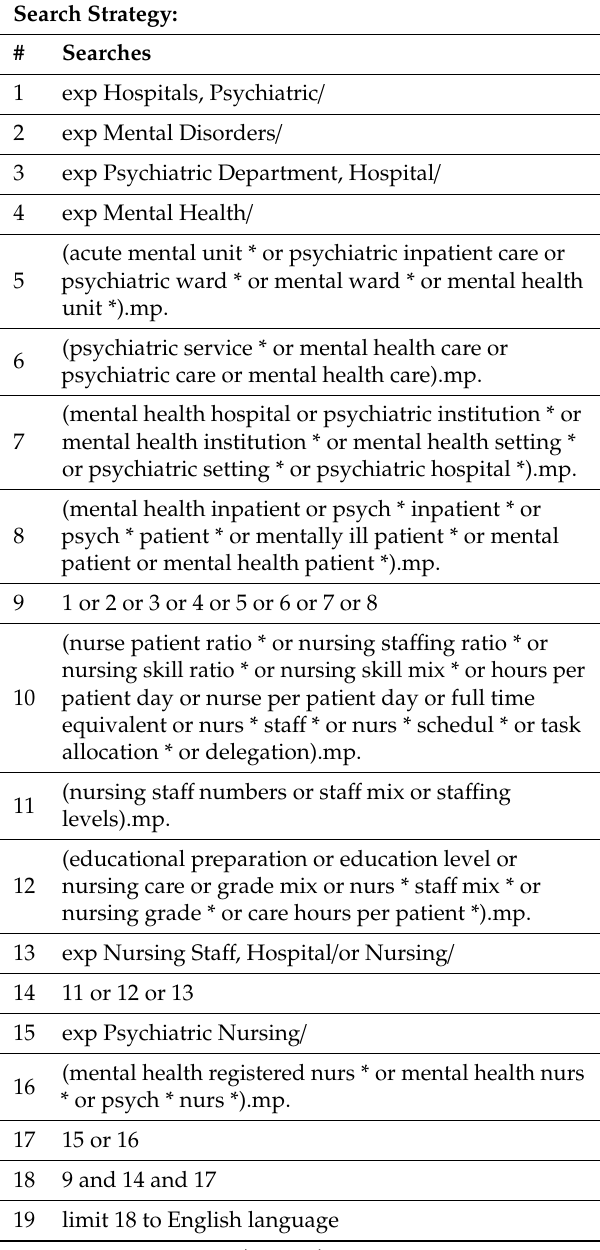
Table 1. Database(s): Ovid MEDLINE(R), ALL 1946 to 30 July